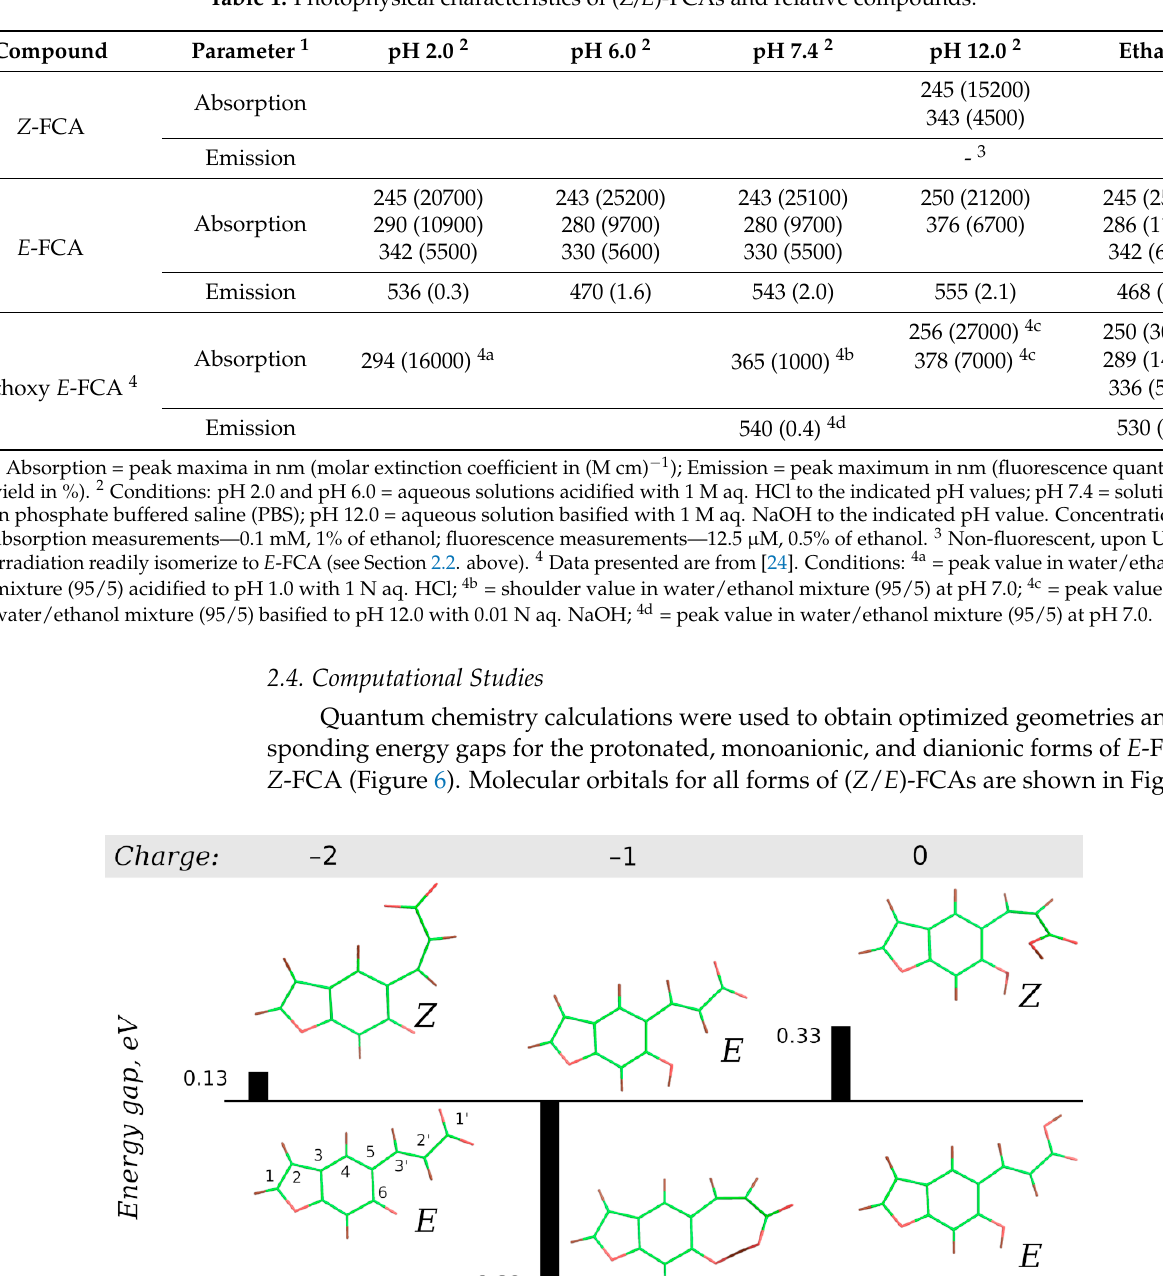
Table 1. Photophysical characteristics of ( Z/E )-FCAs and relative compounds.